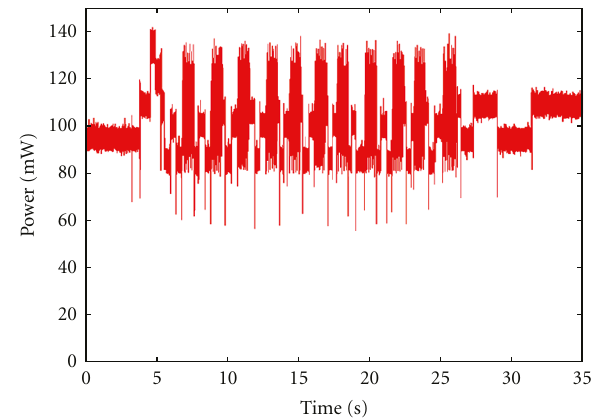
Table 2: Time and Energy for each page of “Pong” under Deluge and PrivCIB.